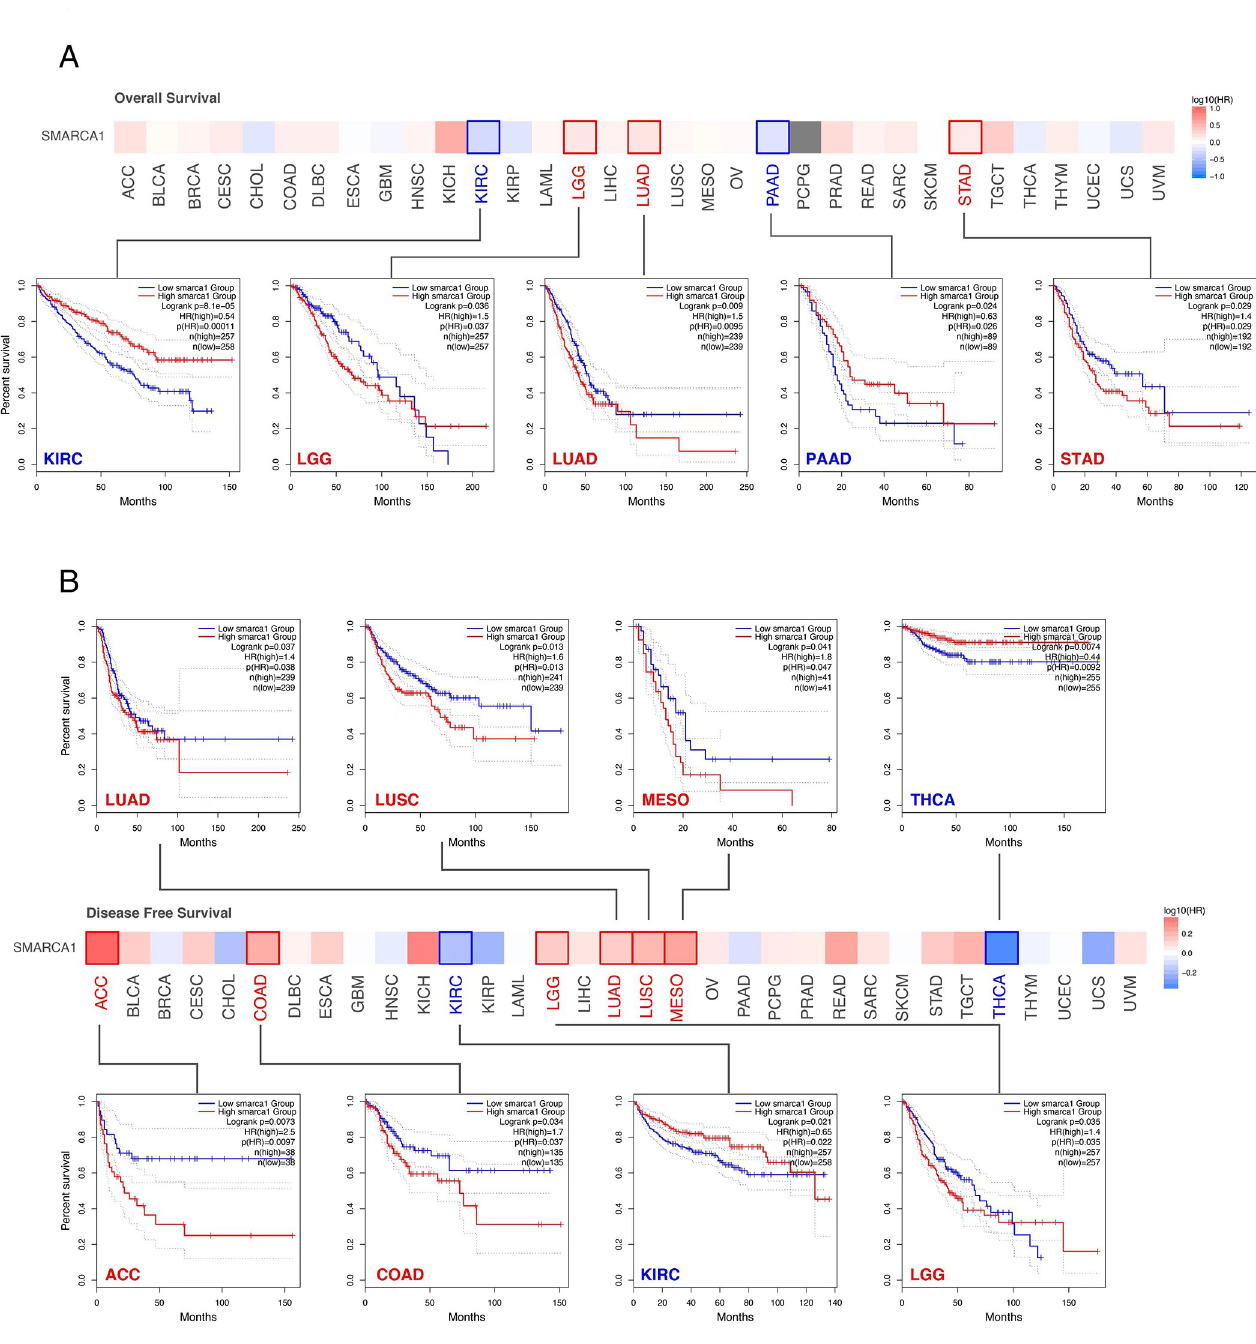
Fig 5. Analysis of SMARCA1 expression associated prognosis different cancers via GEPIA2. (A) Overall survival (OS) analyses between SMARCA1 expression and all cancers included; (B) disease-free survival (DFS) analyses between SMARCA1 expression and all cancers included with demonstration of survival map and Kaplan-Meier